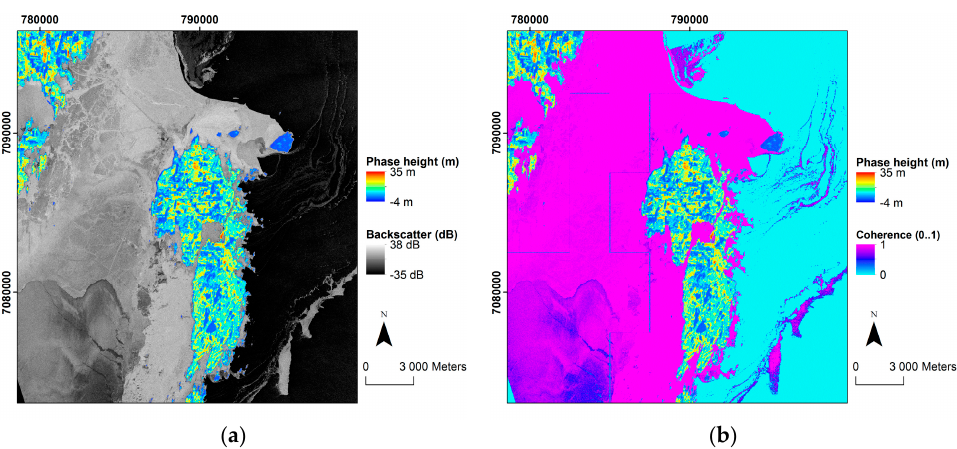
Figure 12. Phase height overlaying ( a ) the backscatter and ( b ) the coherence for a scene in the archipelago outside Umeå in northern Sweden, where the frozen conditions influence the options for using coherence and backscatter to filter out water bodies. The perpendicular lines are processing artefacts originating from the ALS DTM, but since all the water within 0.7 m above the sea-level was filtered away, these areas did not influence any computations.